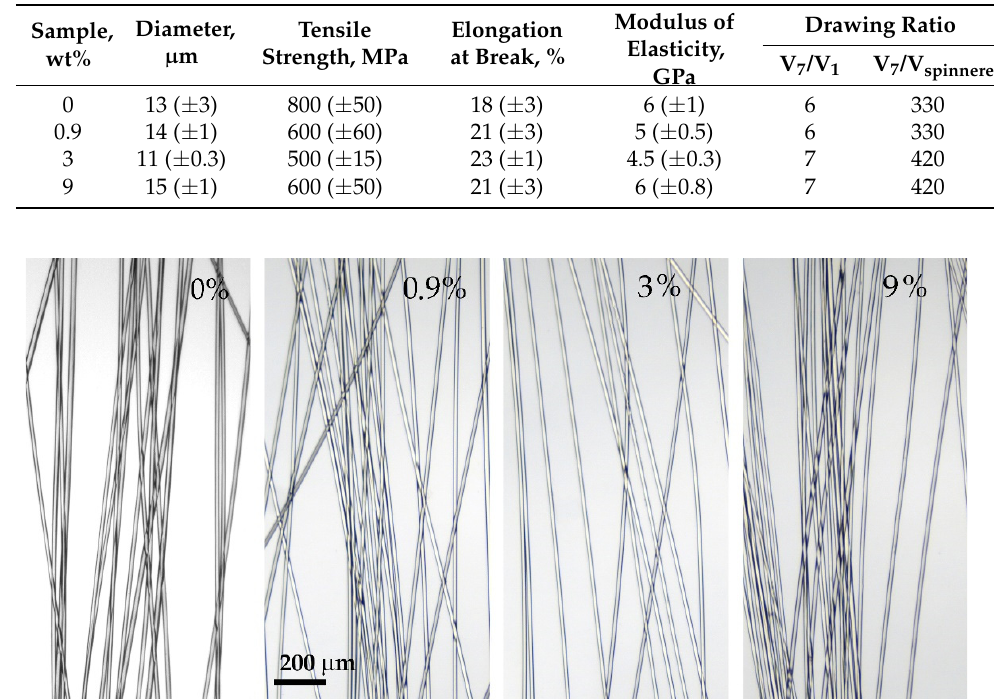
Figure 14. Images of spun fibers made by optical microscopy (at the polymer weight). Of particular interest is the question of the silica distribution into the spun fibers.